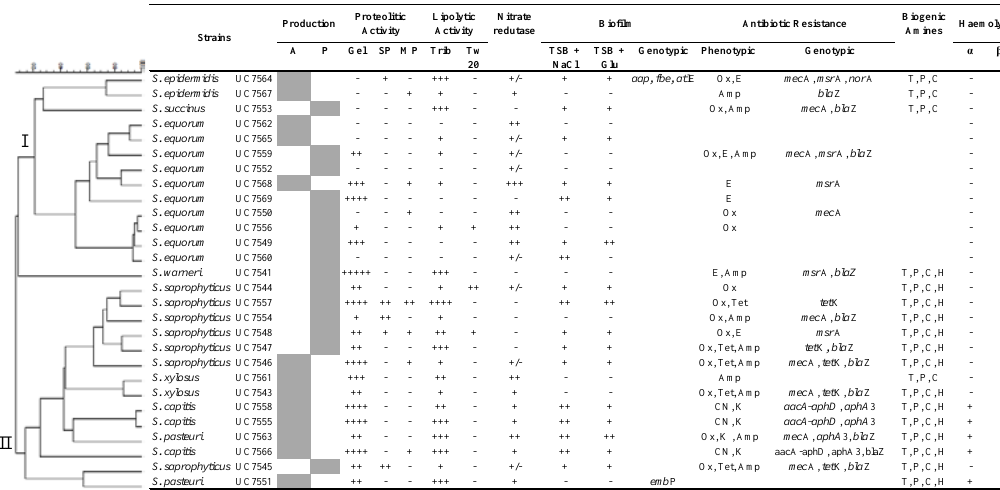
5 of 11 Figure 1. Correspondence analysis biplot of Staphylococcus ( S ) species and type of production (pilot or artisanal). Contribution to Chi-square is indicated in brackets. To investigate their genetic relatedness, 28 biotypes were clustered by UPGMA; dendogram from Figure 2 shows the presence of two main clusters, one containing all S. equorum strains (10), S. epidemidis (2), S succinis (1) and the second cluster grouping all S. saprophyticus (7 strains), S. capitis